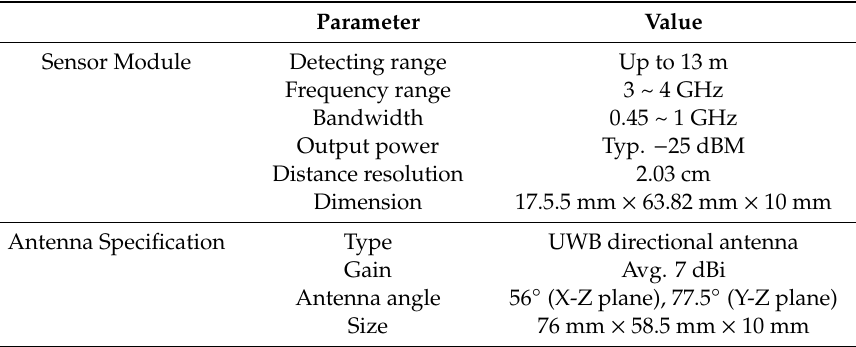
Table 5. Product specification of HST-S1M-SE.